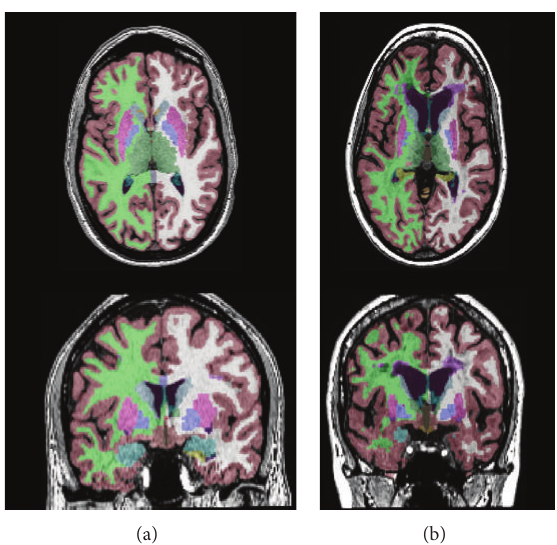
Figure 3: Atrophy in multiple sclerosis as measured using Freesurfer (http://surfer.nmr.mgh.harvard.edu/). (a) Cortical and subcortical seg- mentation in a healthy control patient. (b) Cortical and subcortical segmentation in an age-matched patient with longstanding RRMS. Note the prominent subcortical, white matter, and neocortical atrophy in MS compared to healthy